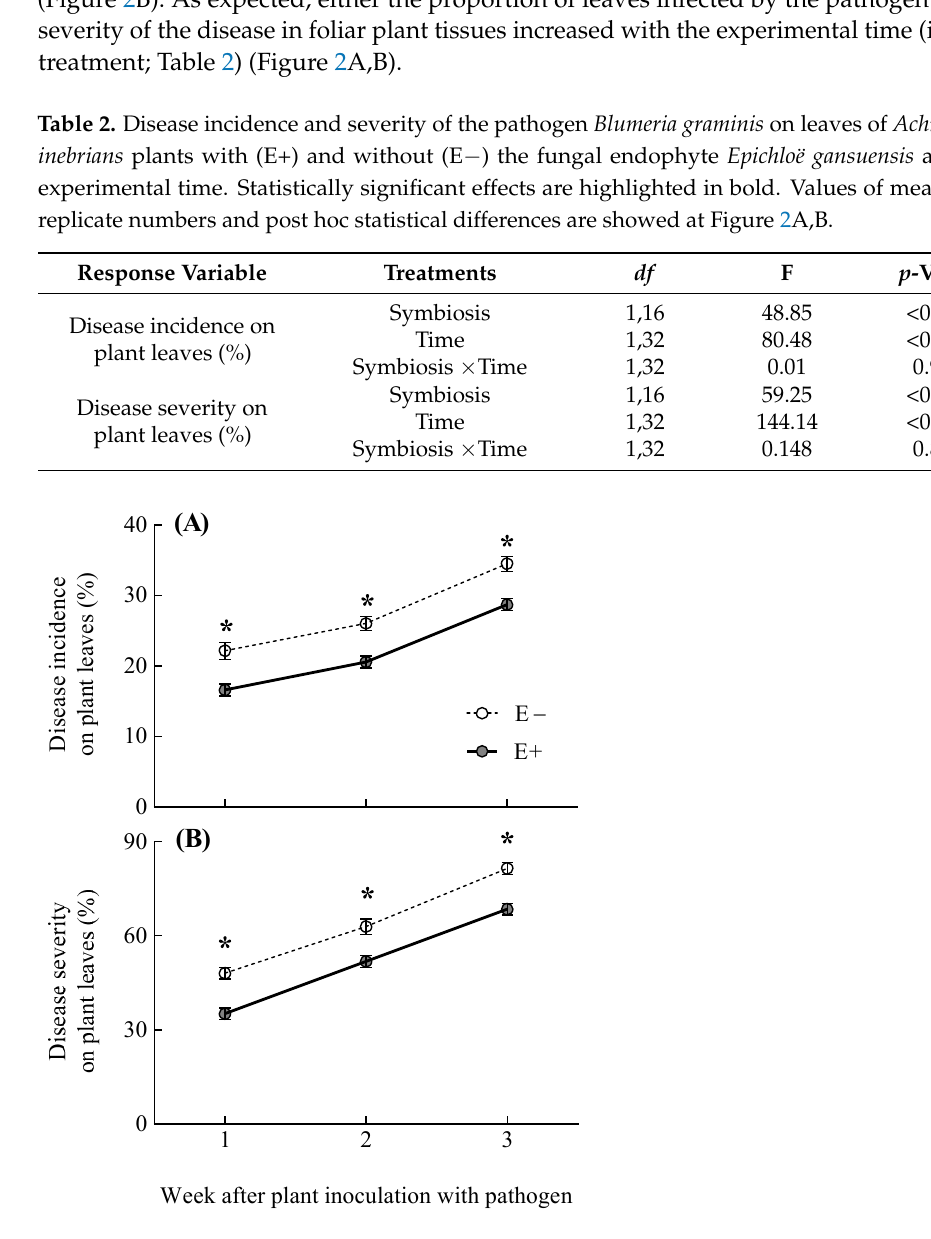
Figure 2. Disease incidence and severity (panels A and B , respectively) of the pathogen Blumeria graminis on leaves of Achnatherum inebrians plants with (E+, shaded circles and solid line) and without (E − , unshaded circles and dashed line) the fungal endophyte Epichloë gansuensis along the experimental time. Asterisks indicate significant differences at p < 0.05 between E+ and E − plants in a particular time. Circles represent means values ± SEM ( n = 9).